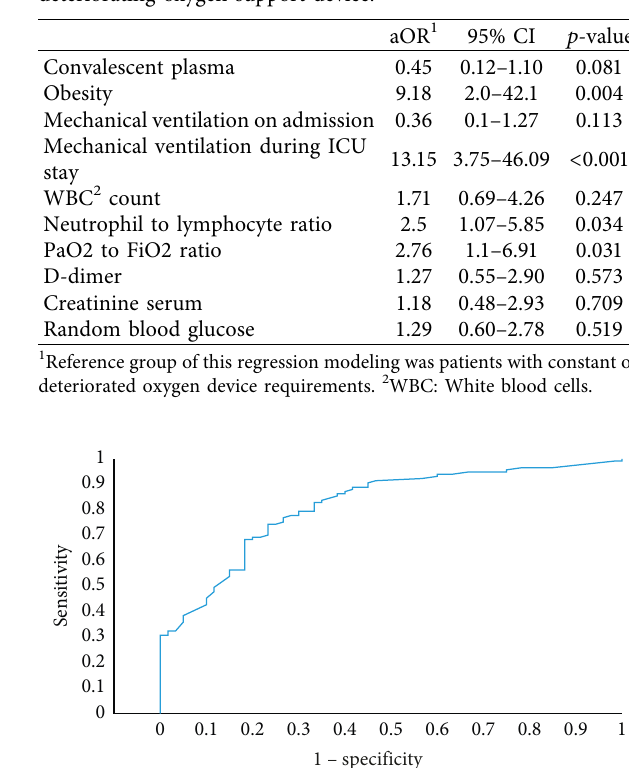
Figure 2: Receiver operating characteristics graph of ICU length of stay prediction model. Table 5: Multivariate analysis on factors confounding constant and deteriorating oxygen support device.